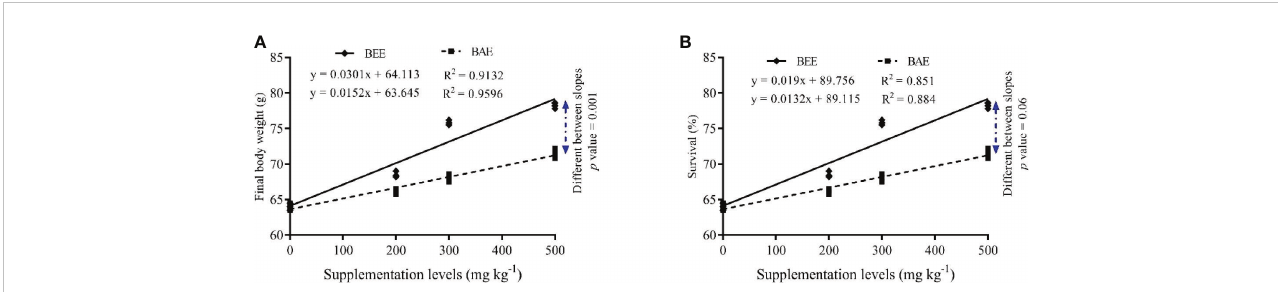
FIGURE 1 The fi t regression model and slope differences between dietary supplementation of basil ethanol (BEE) and aqueous extracts (BAE) on fi nal body weight (A) and survival (B) of Nile tilapia, Oreochromis niloticus .